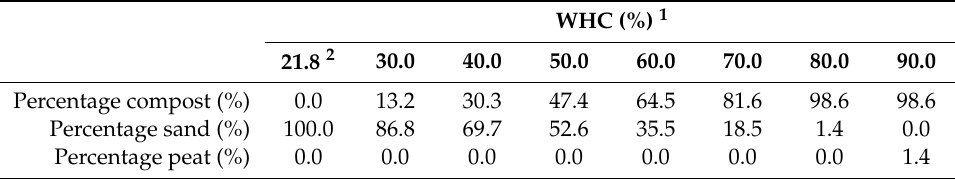
Table 3. WHC of di ff erent mixtures of compost with sand and